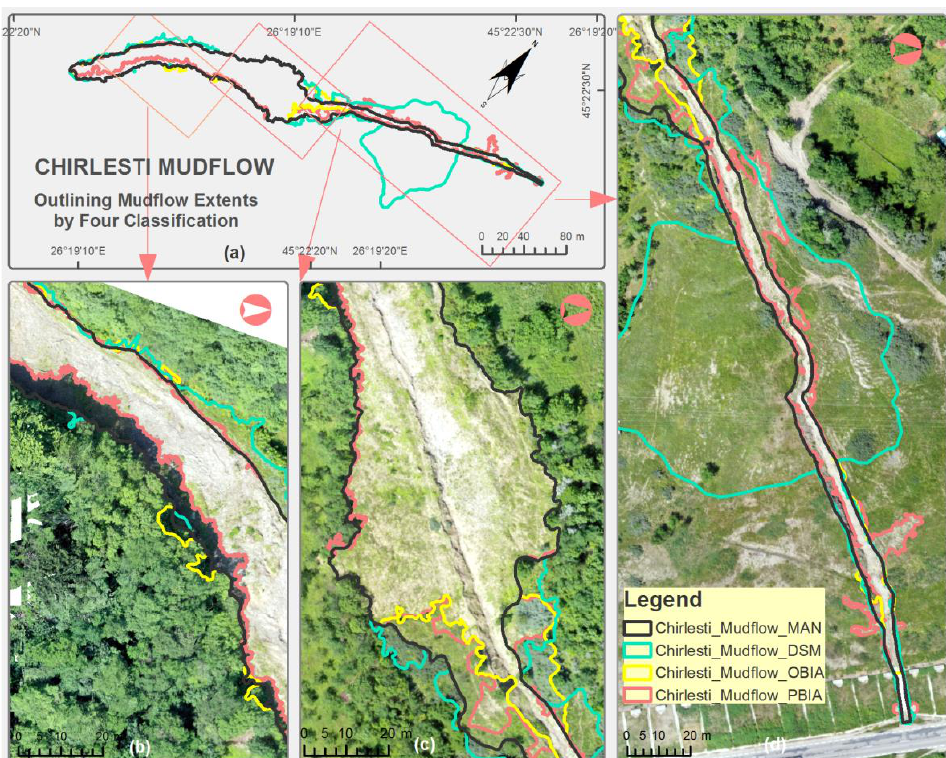
Figure 12. Outlining the extent of landslide boundaries using the four classifications: ( a ) overall extent of four classifications; ( b ) the head zone of the mudslide with trees shows the exposed topsoil is obscured; ( c ) translational zone between erosion and deposition of the mudflow debris; and ( d ) depositional zone of the mudflow debris in the Chirlesti mudflow case study site in Romania. Table 4. The statistics produced by each method for the Romanian site.